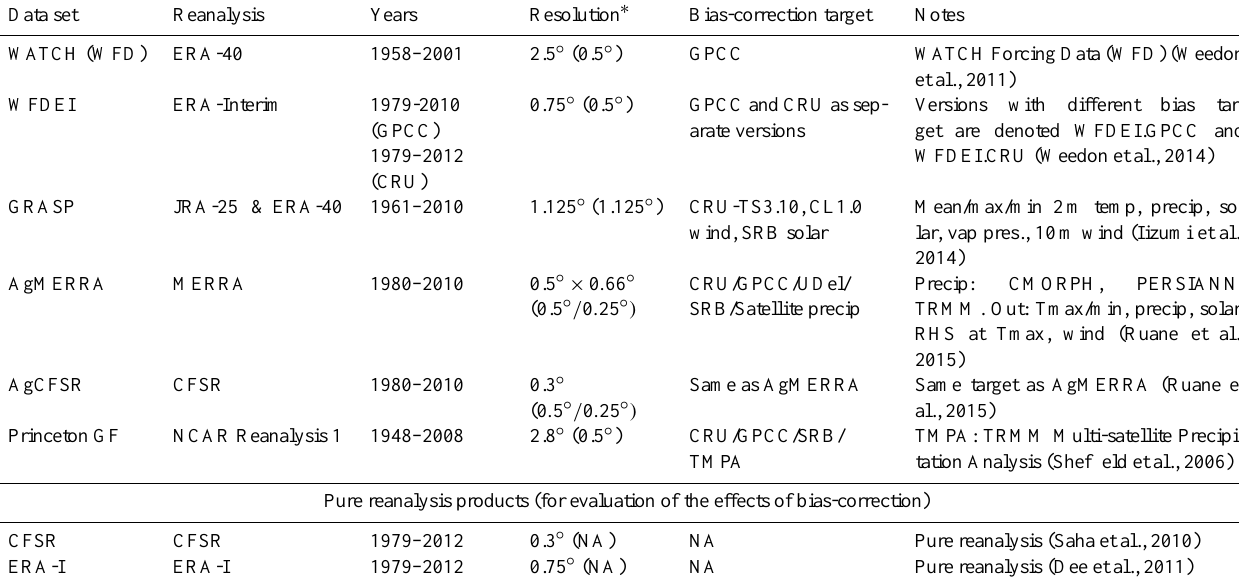
Table 9. Historical climate forcing data sets for Phase